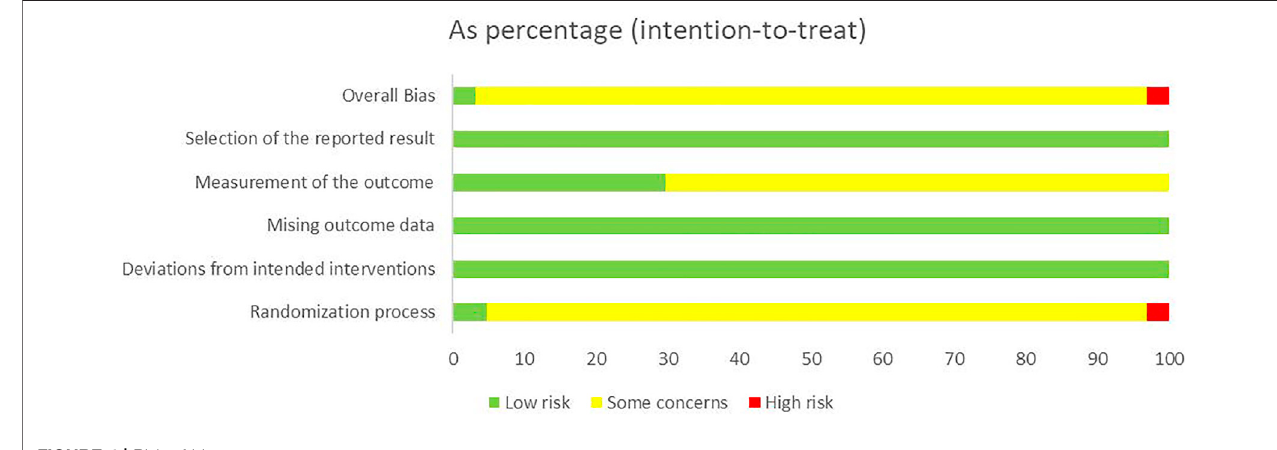
FIGURE 4 | Risk-of-bias summary.